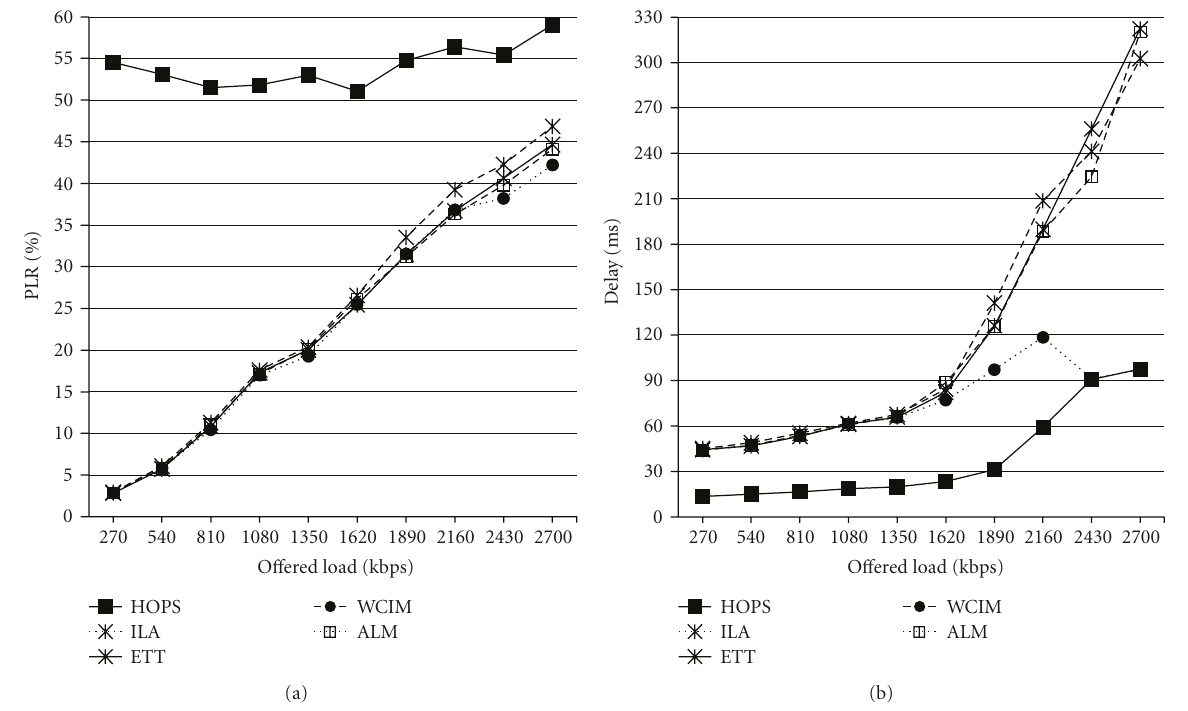
Figure 10: Scenario 5 main results. (a) Packet loss rate. (b) End-to-end delay.